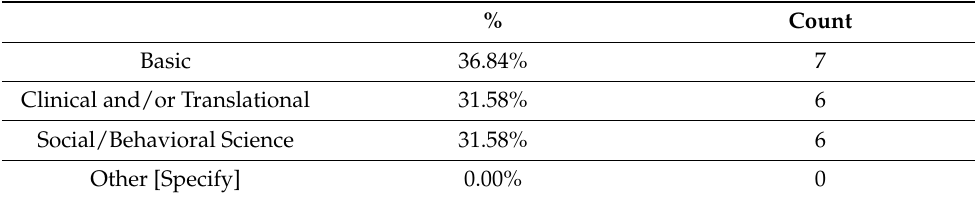
Table 2. Type of Research conducted by participants.